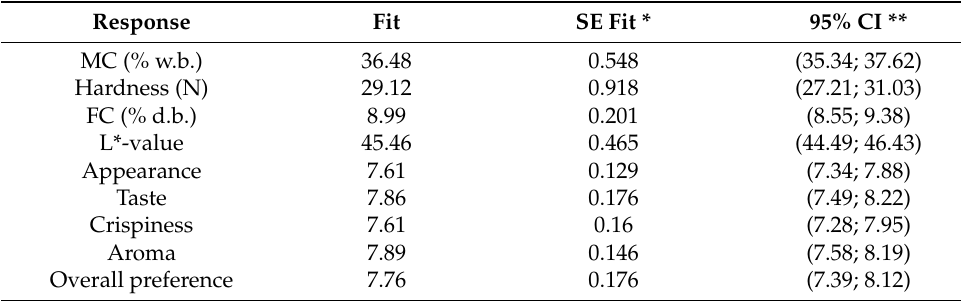
Figure 4. Overlaid contour plots of MC (w.b. %), hardness (N), FC (d.b. %), L*-value, appearance, crispness, taste, aroma, and overall preference of fried falafel as a function of frying temperature and time. Table 3. Predicted responses for the properties of air-fried falafel.